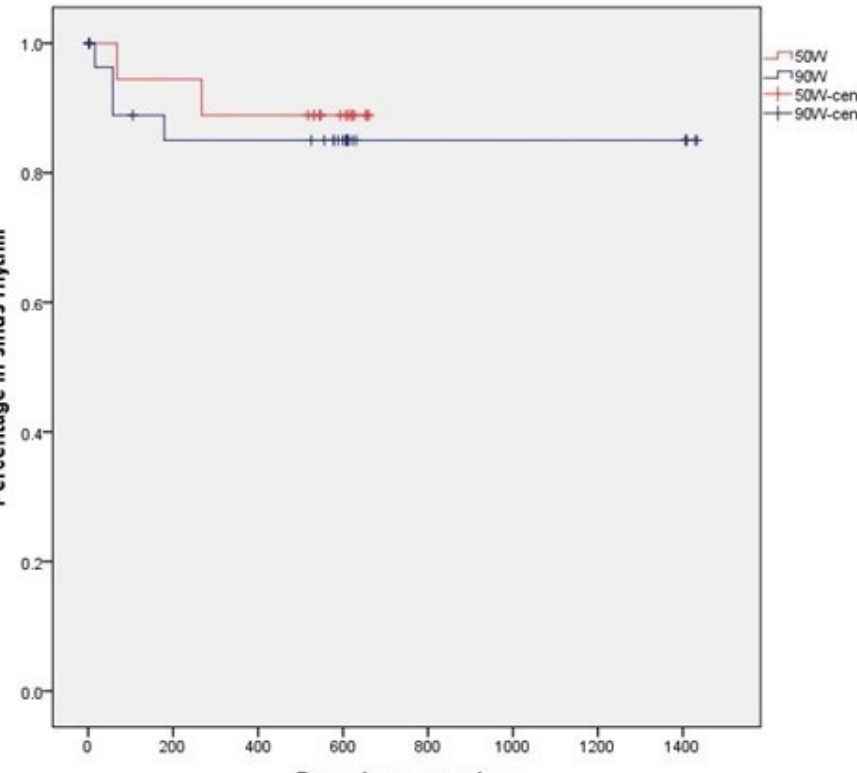
Figure 5. Detailed flow-chart overview of study population.